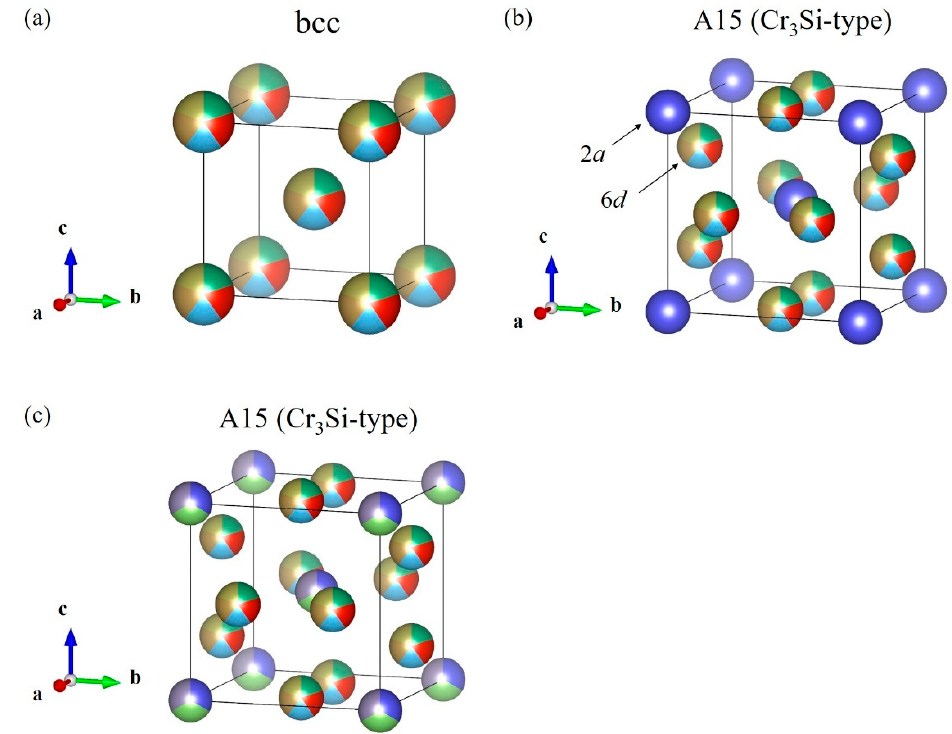
Figure 1. Crystal structures of ( a ) body-centered-cubic (bcc), ( b ) and ( c ) A15 compounds. The multicolored balls mean that the site is randomly occupied by several atoms. The solid lines represent the unit cells.